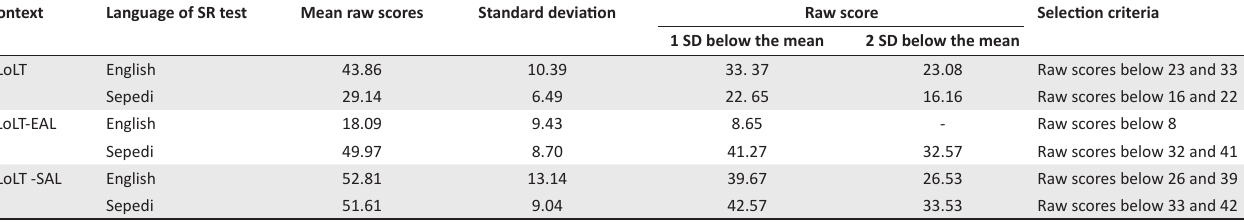
TABLE 3: Criteria for identification of learners with possible specific language impairment in each educational context.